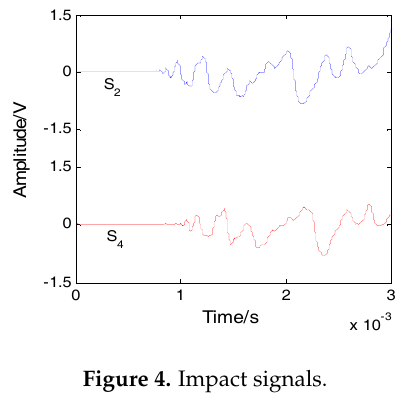
Figure 4. Impact signals.